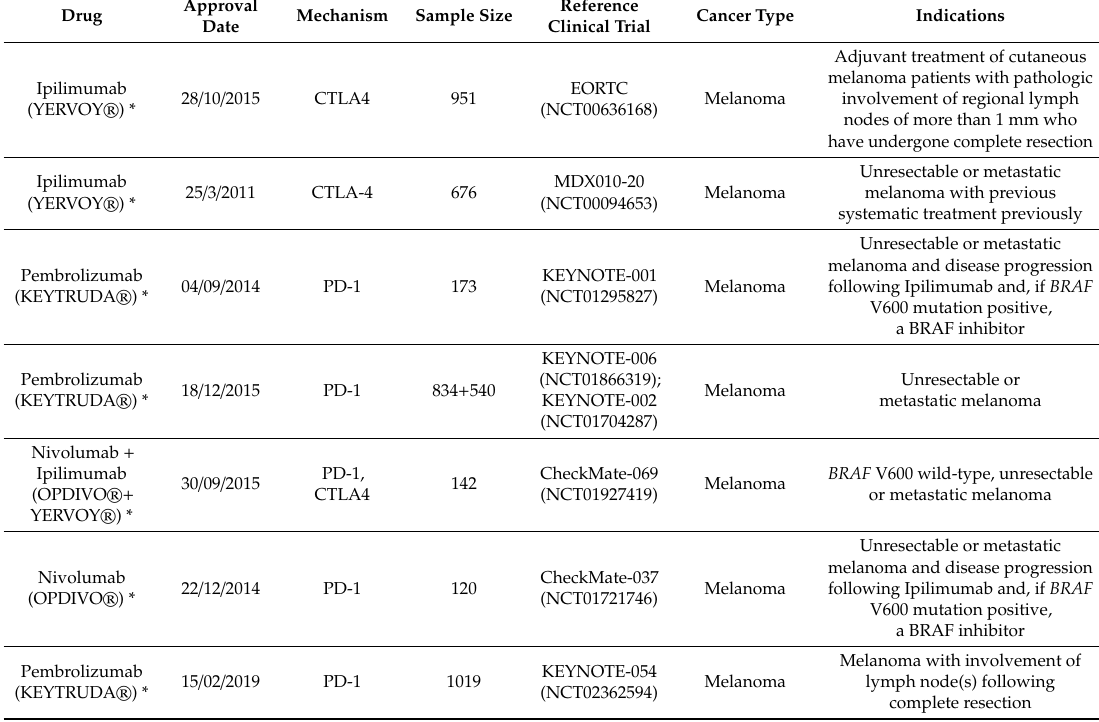
Table 1. Updated FDA approved immune checkpoint inhibitors and their